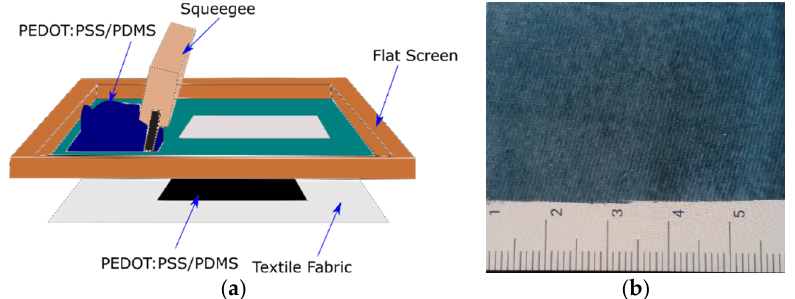
Figure 1. ( a ) The coating of cotton fabric via screen printing, adopted from a previous study [11]; ( b ) actual poly(3,4-ethylenedioxythiophene) polystyrene sulfonate/polydimethylsiloxane-b- polyethylene oxide (PEDOT:PSS/PDMS) coated white cotton